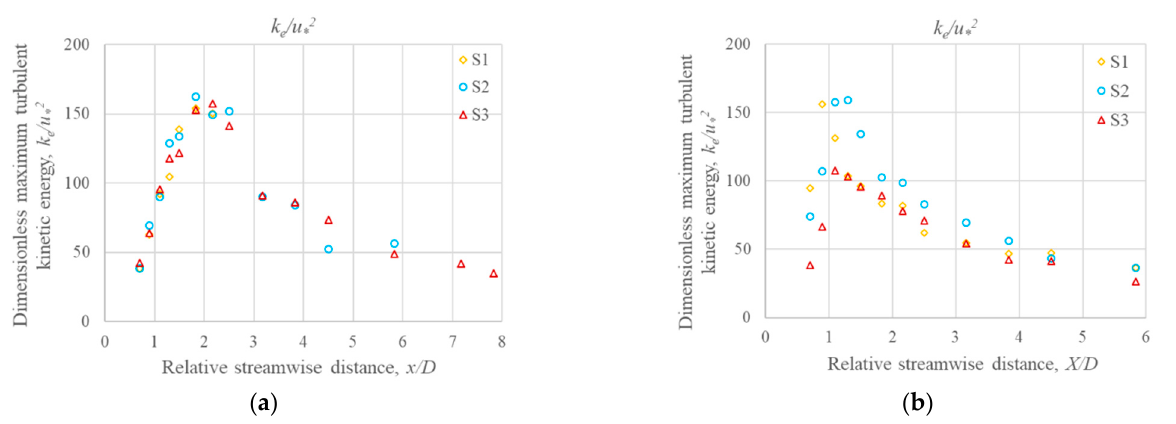
Figure 6. Variation of dimensionless maximum turbulent kinetic energy ( k e /u * 2 ) in the symmetry plane: ( a ) midstream and ( b ) downstream.